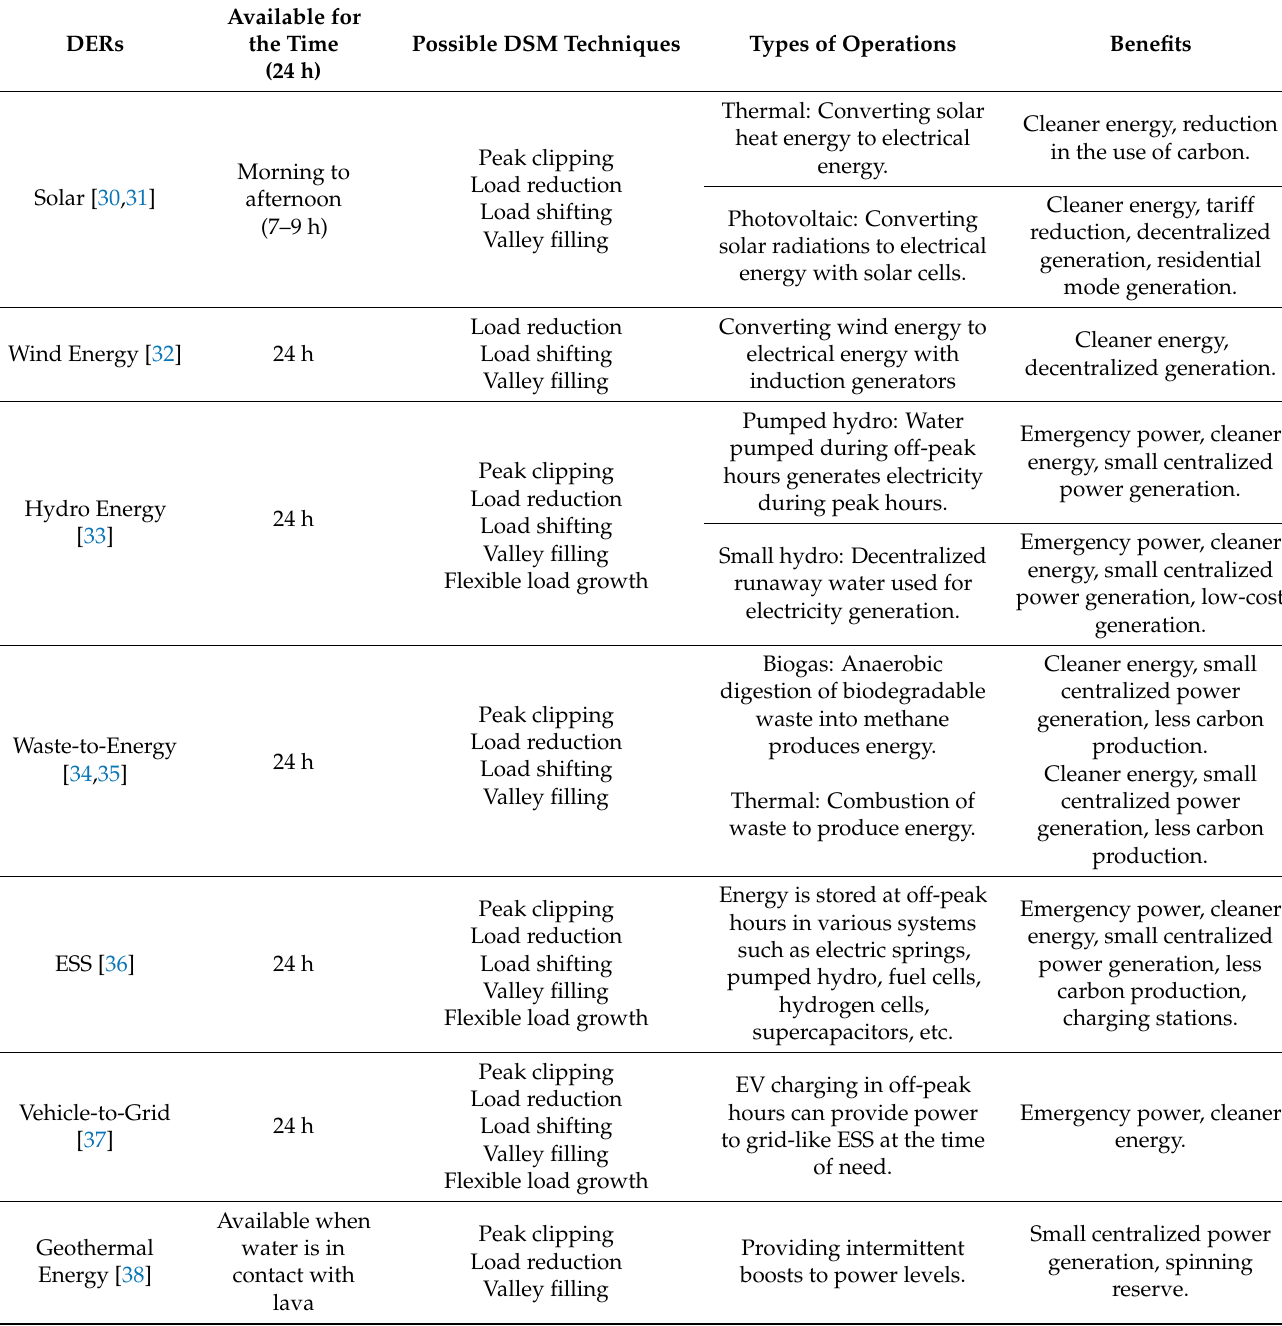
Table 1. Different types of DERs with DSM